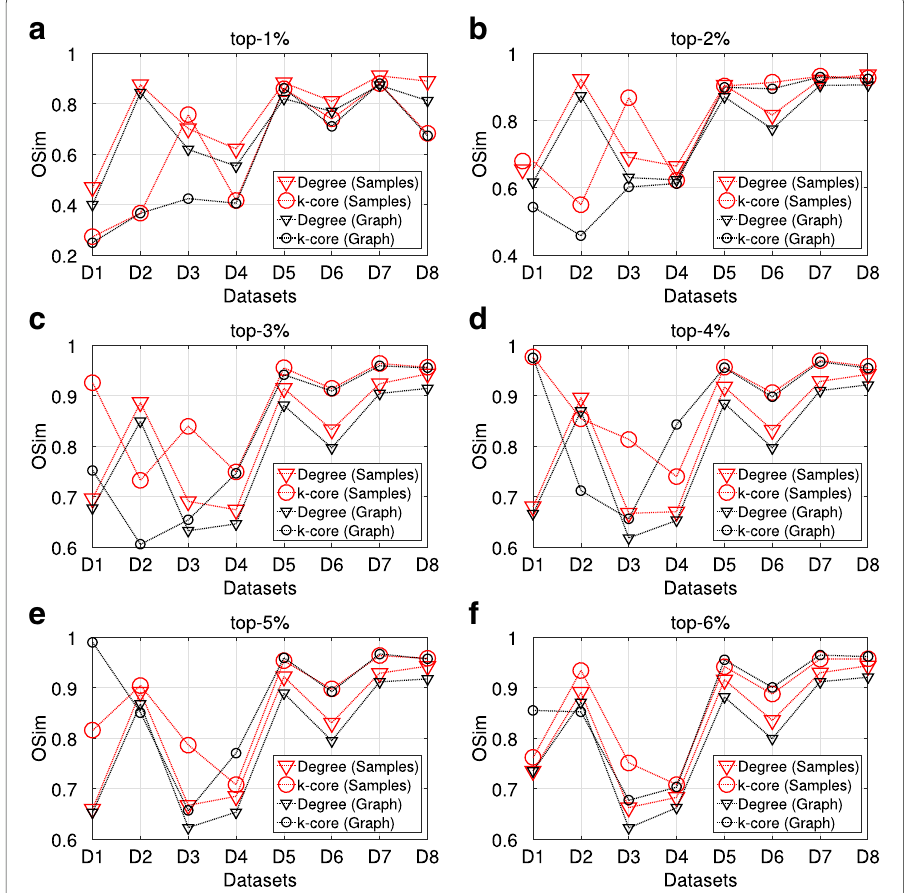
Fig. 3 Top-k nodes similarity, SIR epidemic. a - f Average OSim values in terms of degree centrality and k-core obtained from the maxRD samples, as well as from the original